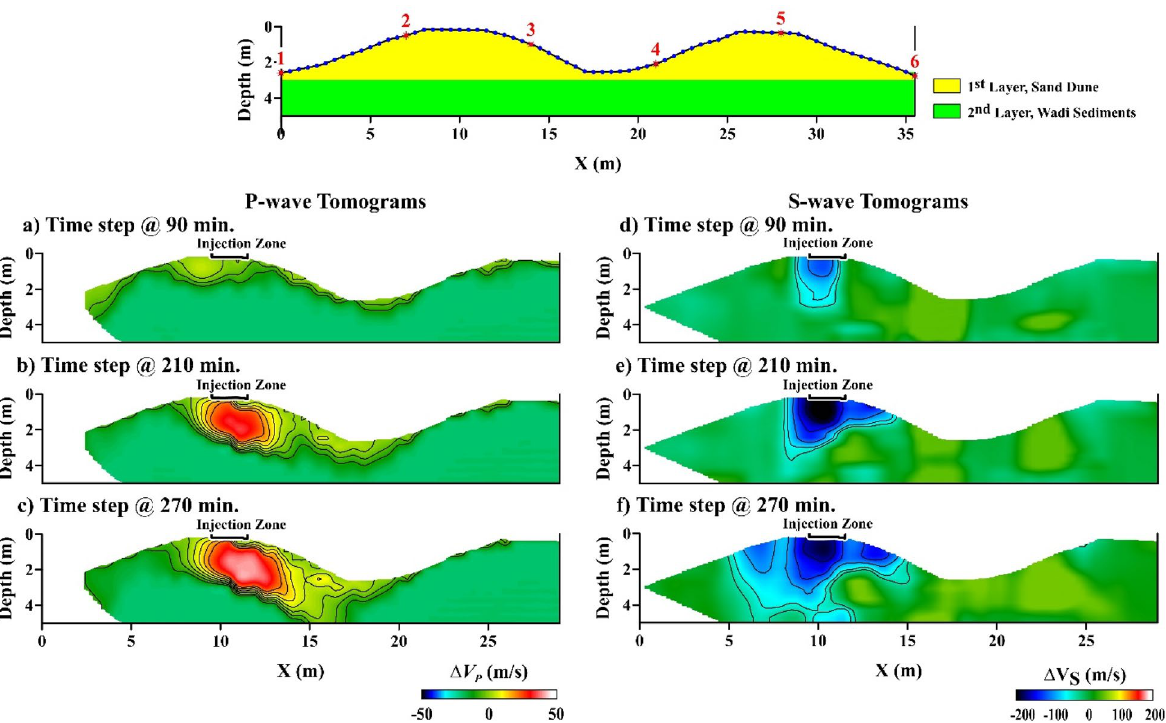
Figure 3. Time-lapse difference tomograms computed by parsimonious interferometry. The top diagram depicts the configuration of the six-sources (red asterisks) and 72-receivers (blue dots) located at the top of the sand dune (yellow layer). Figures ( a – f ) are the velocity changes, relative to the background tomograms computed prior to water injection, in the (left column) P-velocity and (right column) S-velocity tomograms for different recording times. Surfer 11 (https:// www. golde nsoft ware. com/ produ cts/ surfer) is used to plot this